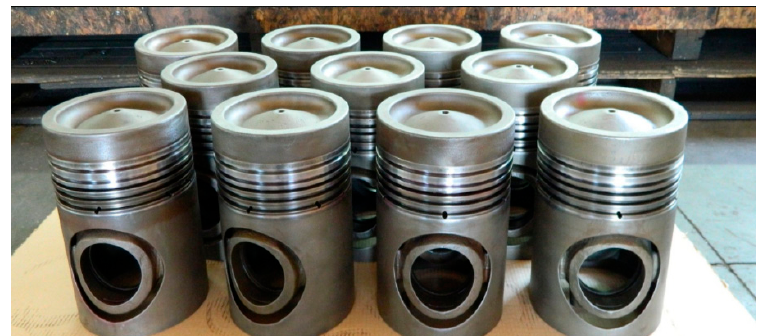
Figure 12. Four-stroke pistons repaired by DED (Courtesy of KIMI) [88].